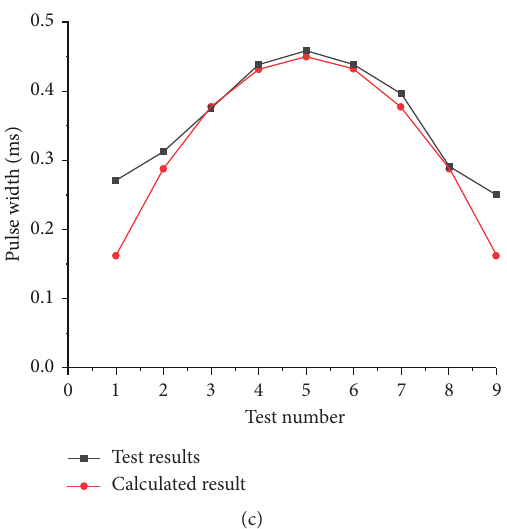
Figure 8: Curve comparison chart of test results and calculated results. (a) Defect 1. (b) Defect 2. (c) Defect